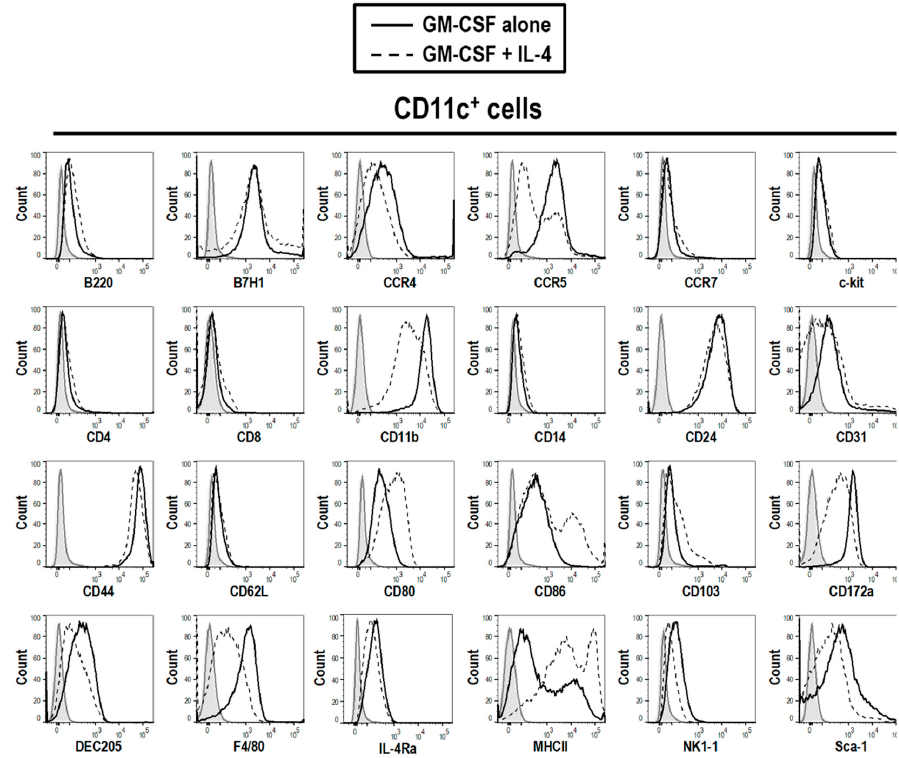
Figure 2. The phenotype of cells from GM-CSF treated BM cultures is consistent with the presence of DCs. Live cells from GM-CSF derived BM culture were characterized on day 3. Cells generated from BM with GM-CSF (10 ng / mL) (solid line) or GM-CSF (10 ng / mL) + IL-4 (5 ng / mL) (dotted line) were characterized with a panel of phenotypic markers, chemokine receptors and activation markers. The shaded grey area represents unstained control cells. Results shown are representative of three mice.